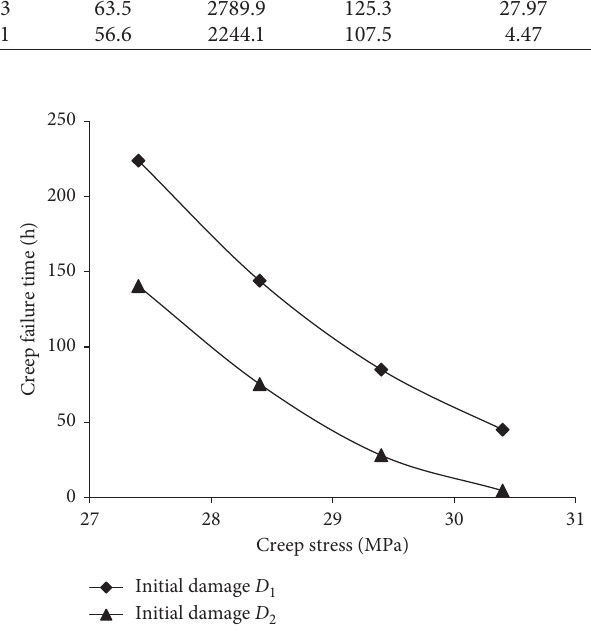
Figure 12: Relationship between the creep stress and the creep failure time of rock specimens with initial damage D 2 and D 3